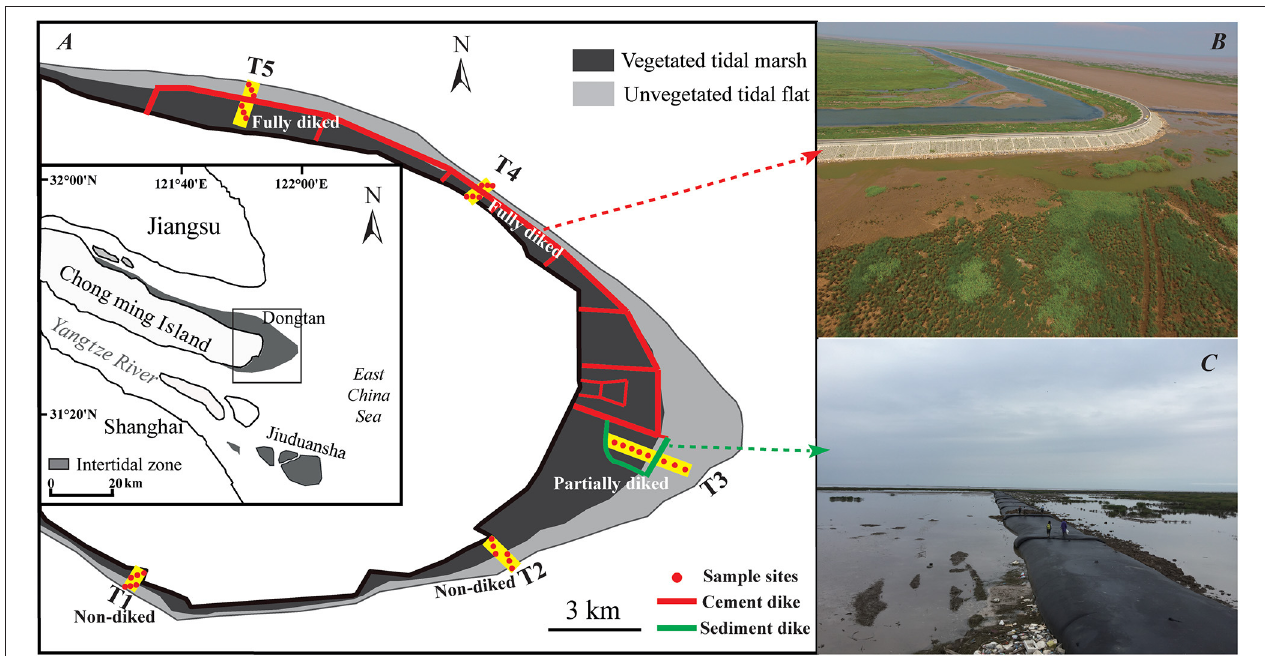
FIGURE 1 | Studyarea in the Chongming Dongtan salt marsh, Yangtze Estuary, China. The area surrounded by red and green lines was the Spartina Control and Bird Habitat Optimization Project Area. The quantitative sampling of macrobenthos was carried out before and after the construction of the diking project in 2013 and 2016, respectively. T1 and T2 were the non-diked projects as an observation area of natural changes. T3 was a partially diked project semi-enclosed by sediment dike. T4 and T5 were the fully diked projects enclosed by cement dike. In the T3–T5 from the project area, all sites inside the project are shown as treatments, while outside sites, as control areas. (A) is the overall drawing, (B) is cement dike in enclosed project area and (C) is sediment dike in semi-enclosed